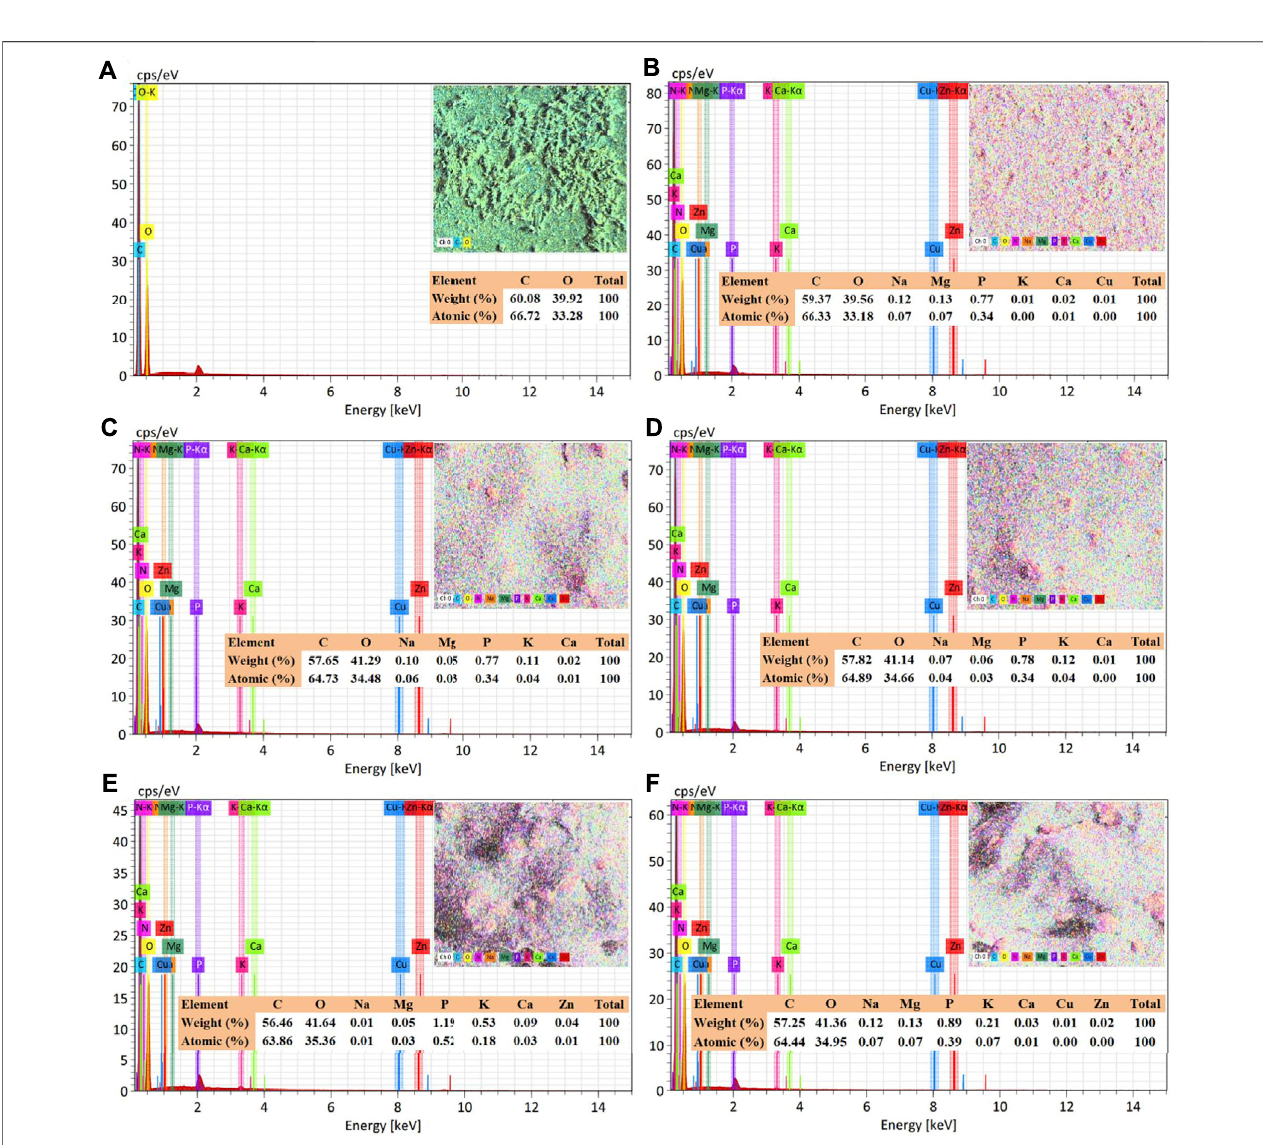
FIGURE 3 | Representative EDS images showing elemental contents of (A) Pure PBS and PBS/BP blends at: (B) 90/10; (C) 80/20; (D) 70/30; (E) 60/40; (F) 50/ 50 wt%.